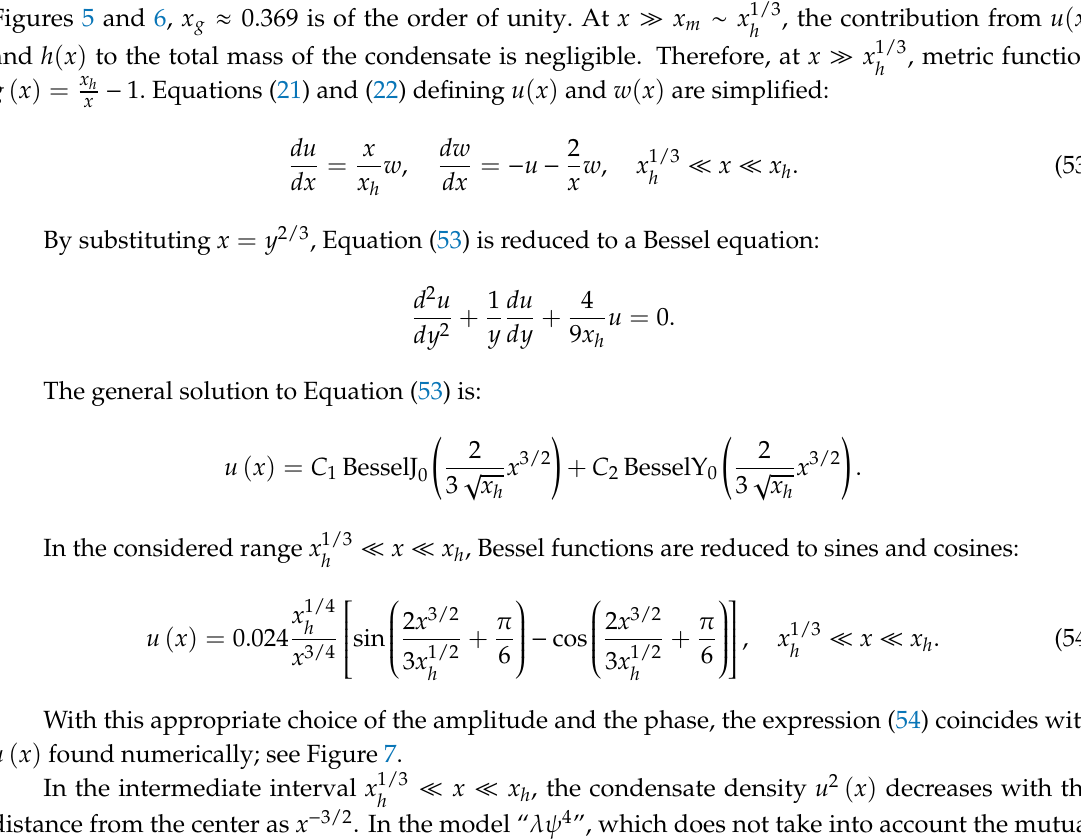
2 = 22 ; and x 2 = 2 : 99985 u . Green line is (cid:0) g g g